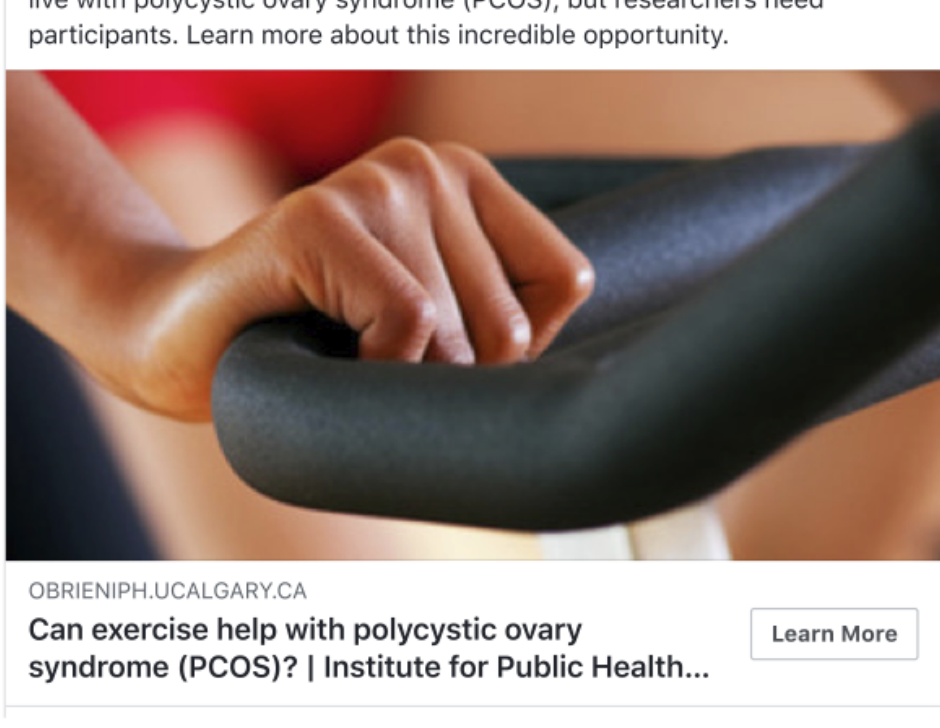
Figure 1. Facebook advertisement run in July